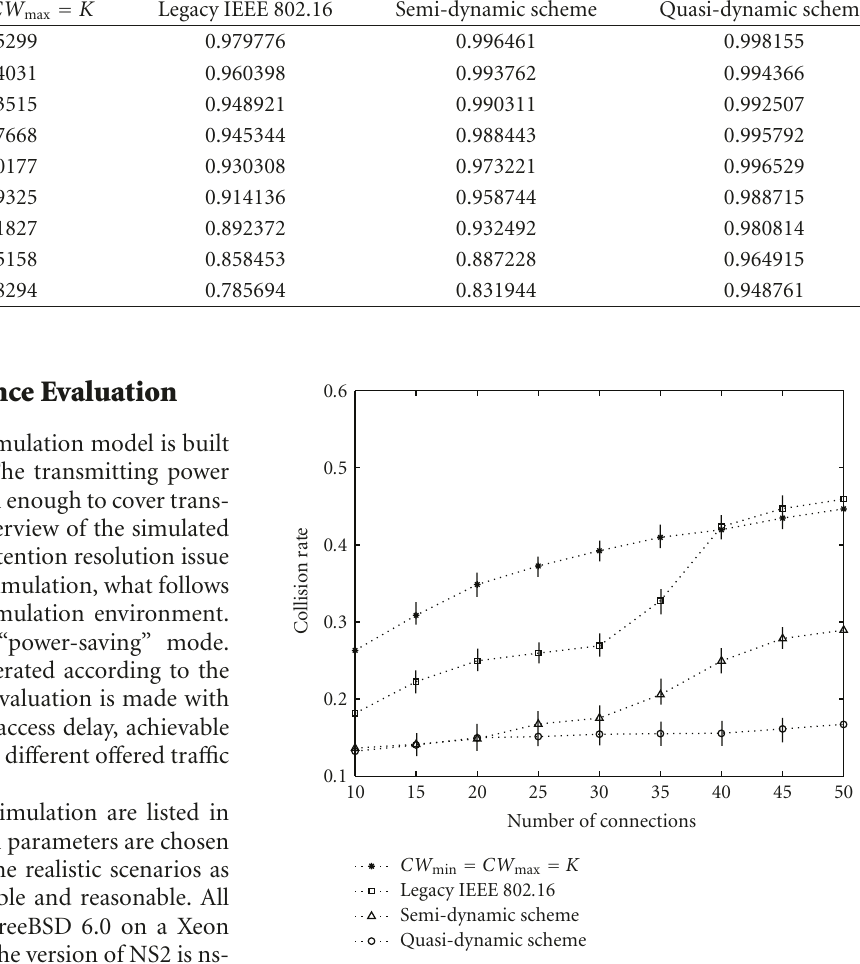
Figure 6: Collision rate versus number of